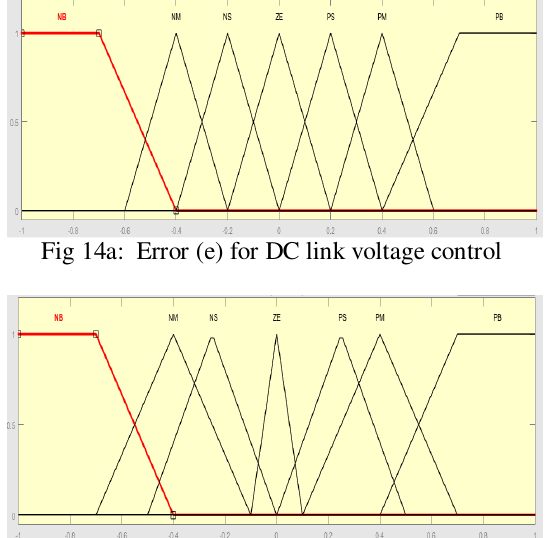
Fig 14b: Change in Error ( Δ e) for DC link voltage control